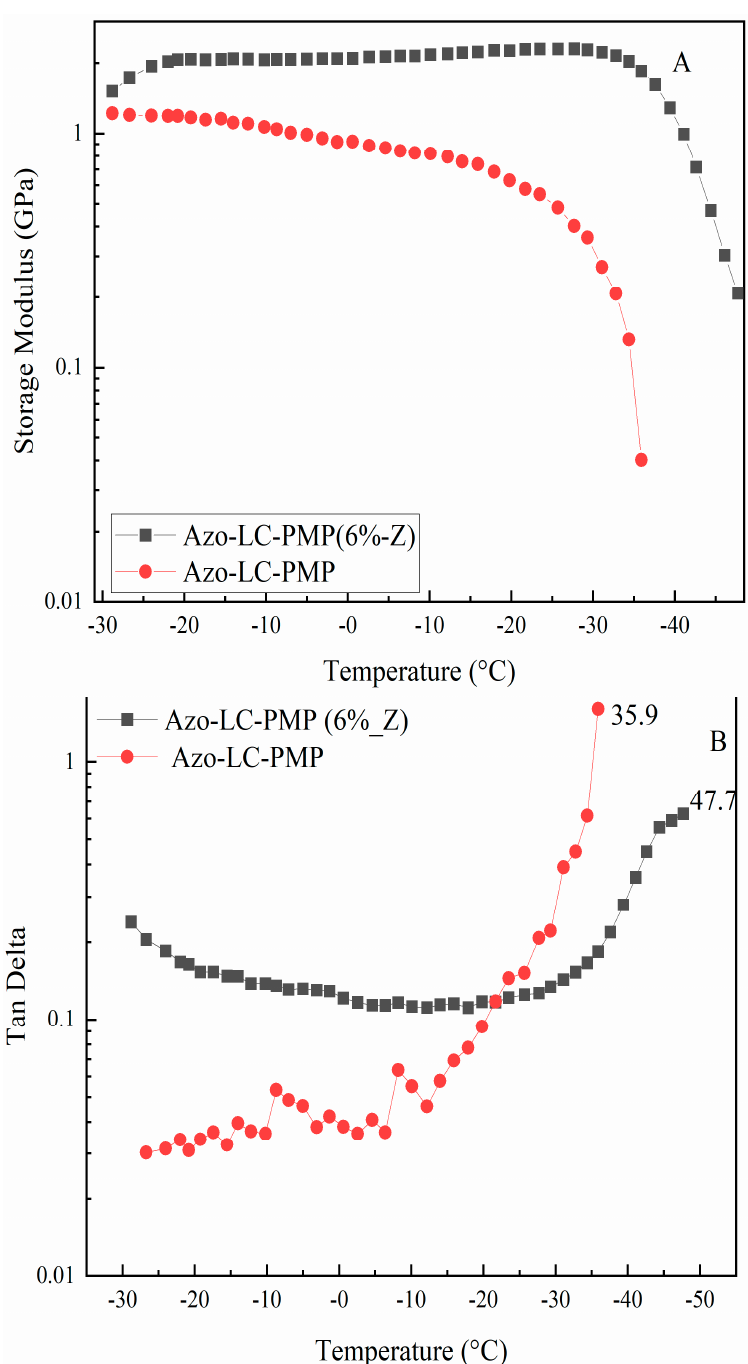
Figure 7. Thermogravimetric analysis of bare and doped PMP film, showing the degradation as a function of the temperature.